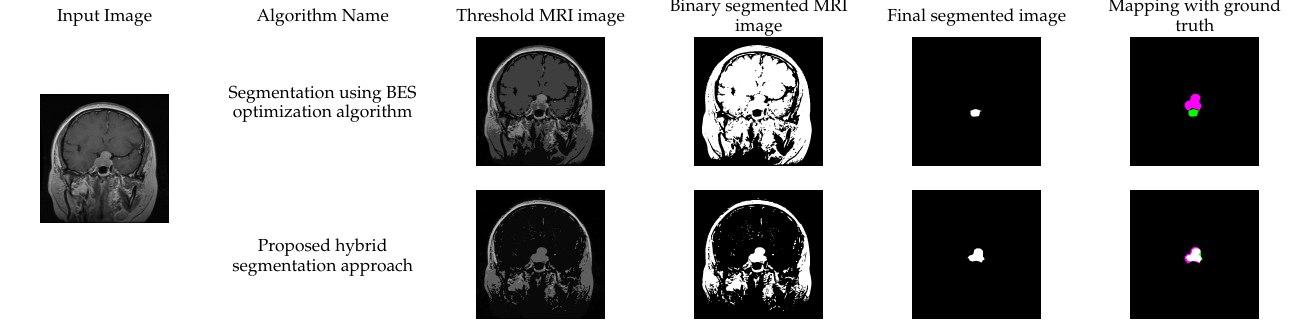
Figure 6. Visual representation of the MRI images generated at different phases of proposed hybrid segmentation approach.